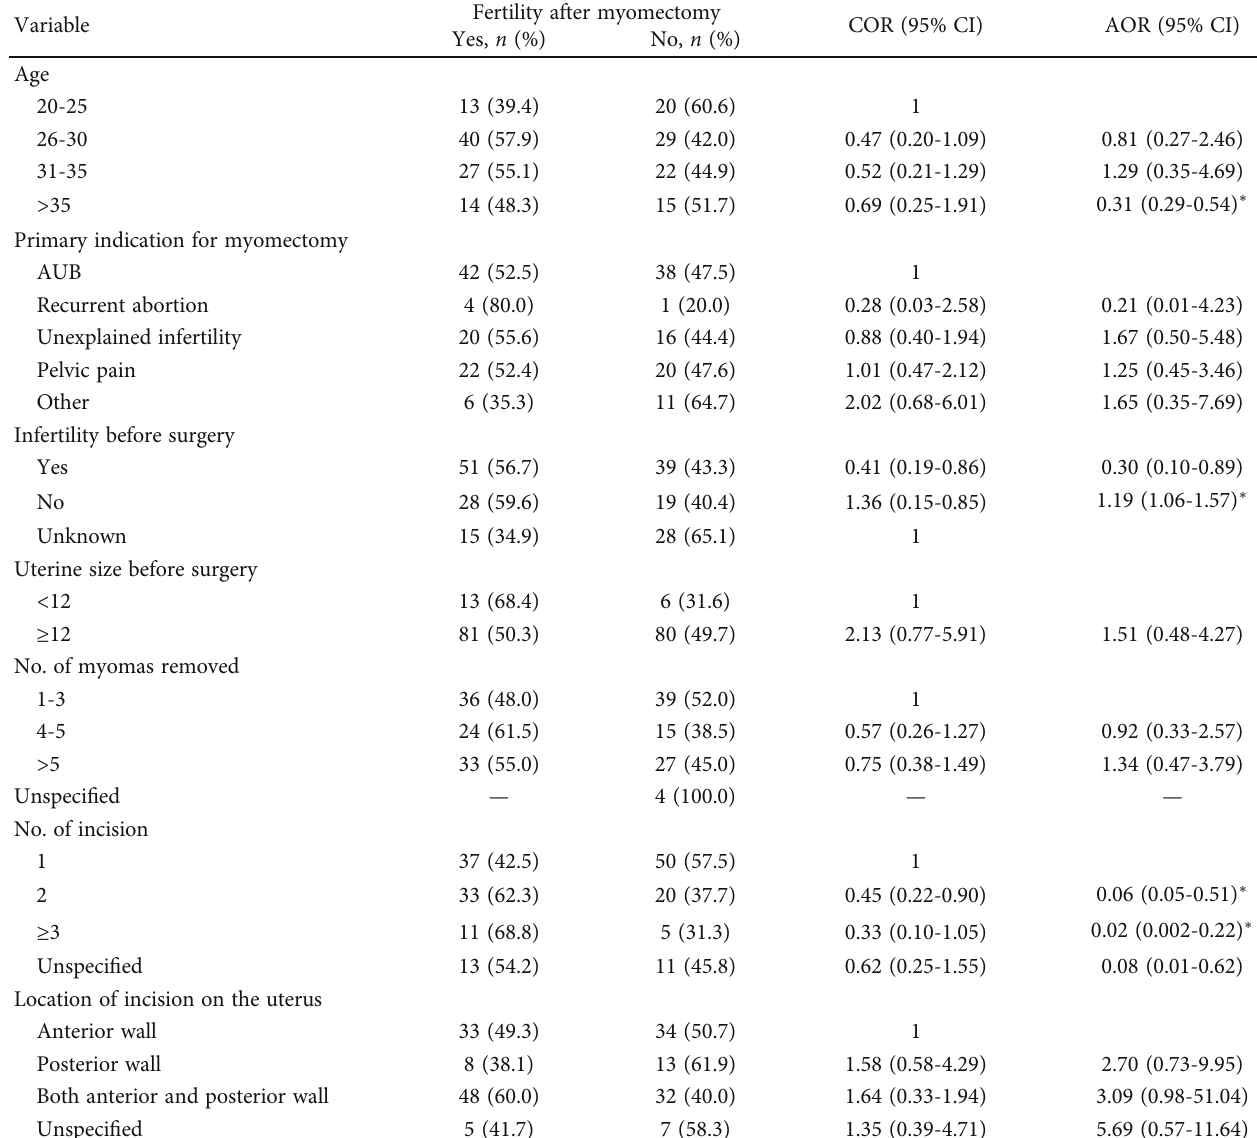
Table 4: Bivariate and multivariate logistic regression analysis of factors associated with fertility after myomectomy, SPHMMC, Addis Ababa,